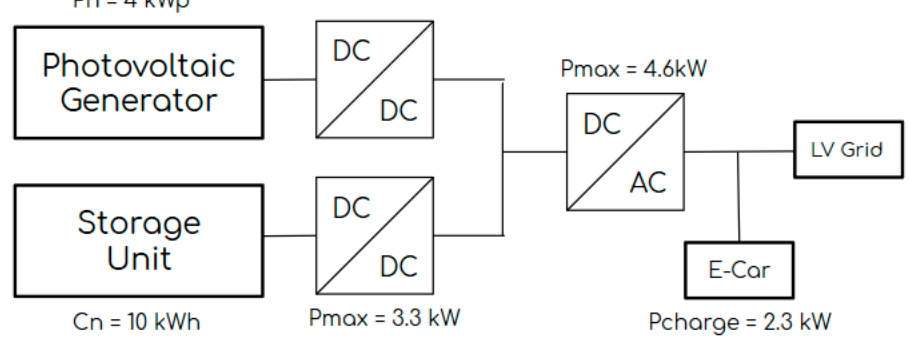
Figure 1. Block diagram of the system considered in this study.